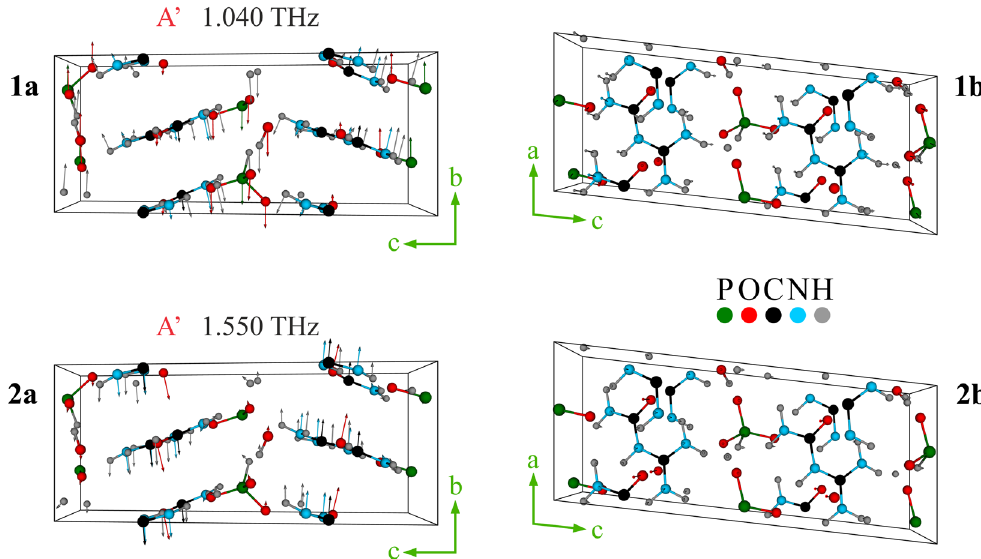
Figure 5. Visualization of the low-frequency vibrational modes of A’ symmetry of GUHP crystal at 80K. The axes indicate crystallographic axes abc . 1 a , 1 b represent 1.040 THz mode for a and b cut crystal planes respectively. 2 a , 2 b represent 1.550 THz mode for the a and b cut crystal planes